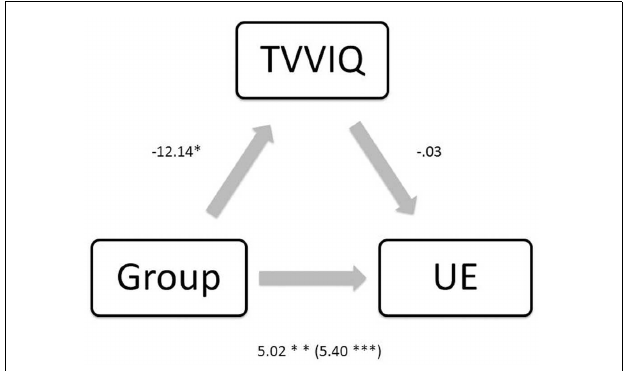
FIGURE 3 | Regression coefficients for the relationship between group and UE (schizotypy) are not mediated by TVVIQ (imagery). ∗ p < 0.05, ∗∗ p < 0.01, ∗∗∗ p < 0.001.